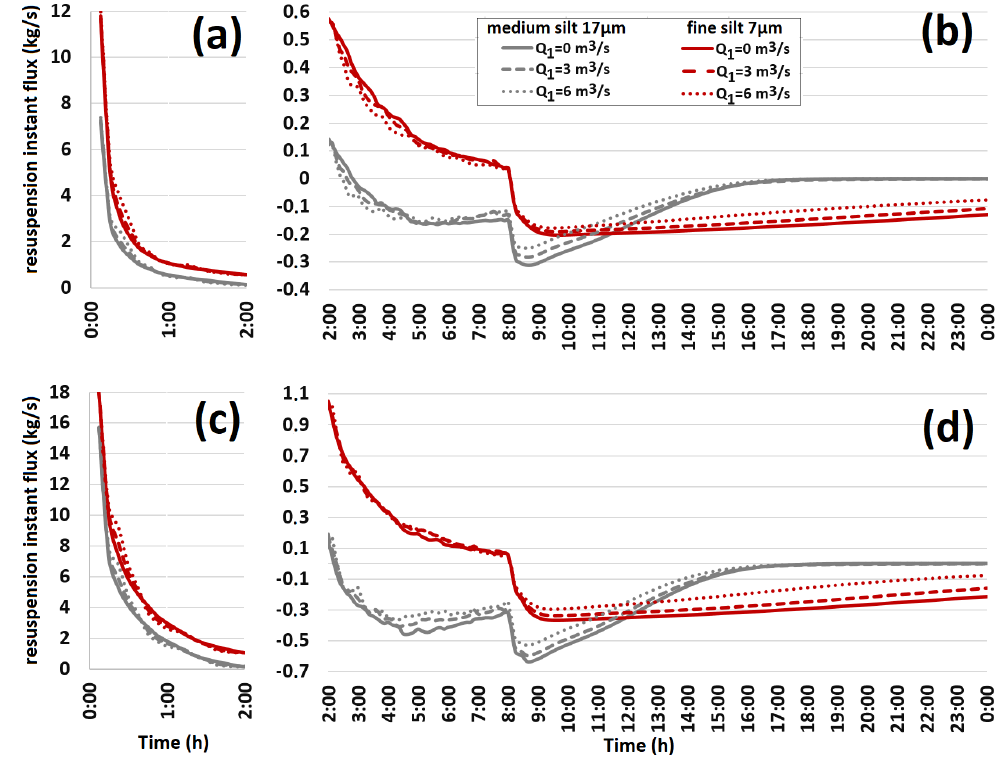
Figure 10. Instant resuspention fluxes (kg/s) of medium and fine silts, for Q 1 = 0, 3 and 6 m 3 /s, ( a , b ) for the case of N-NW wind, and ( c , d ) for the case of S-SE wind. Positive values of resuspension fluxes correspond to erosion, negative values—to sedimentation